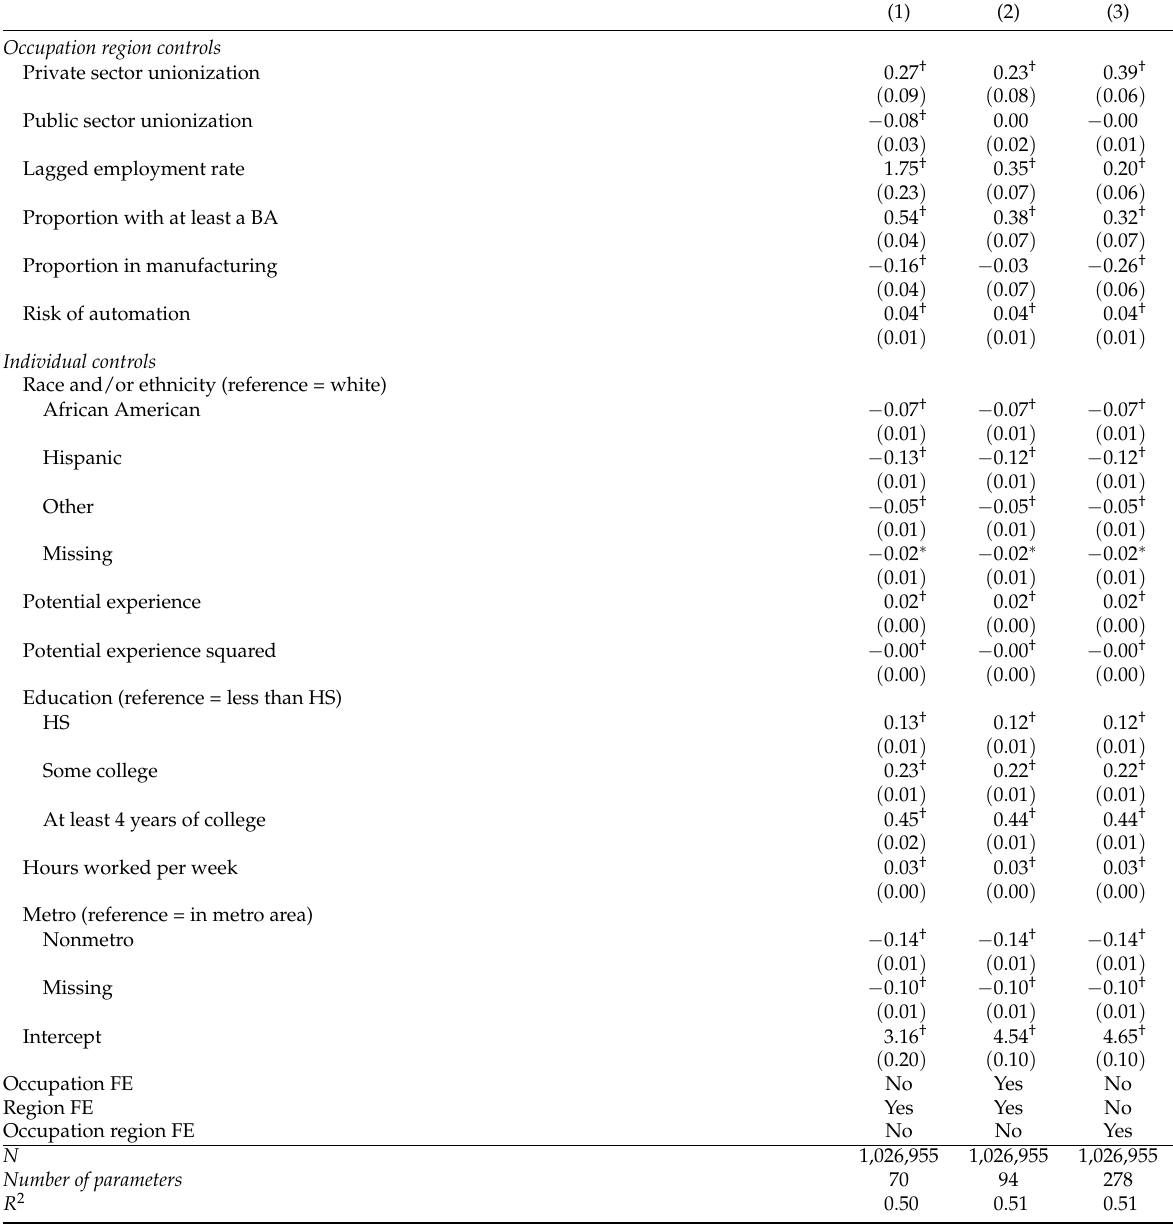
Table 3: Effects of private sector occupation region unionization on nonunion, private sector log weekly wages, 1977–2015